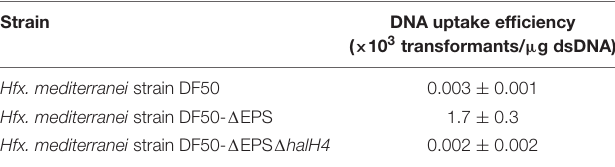
TABLE 3 | Influence of the hal H4 on DNA uptake